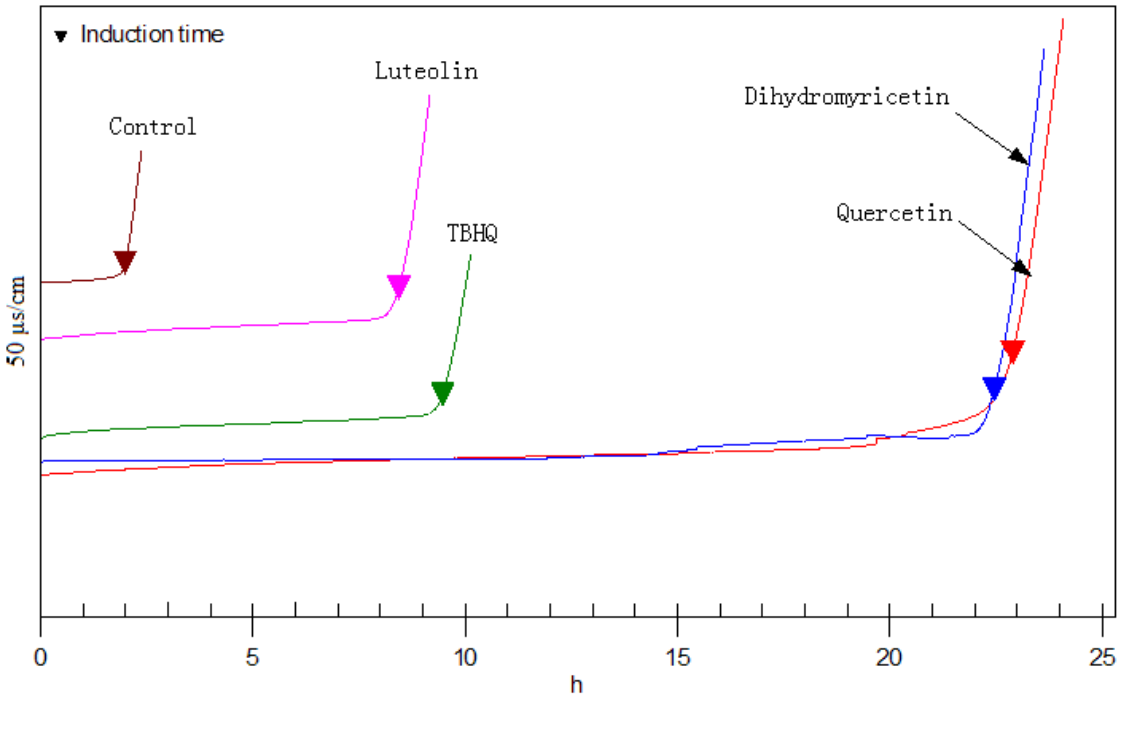
Figure 1. Antioxidant activity of luteolin, dihydromyricetin, quercetin and TBHQ in the Rancimat test.